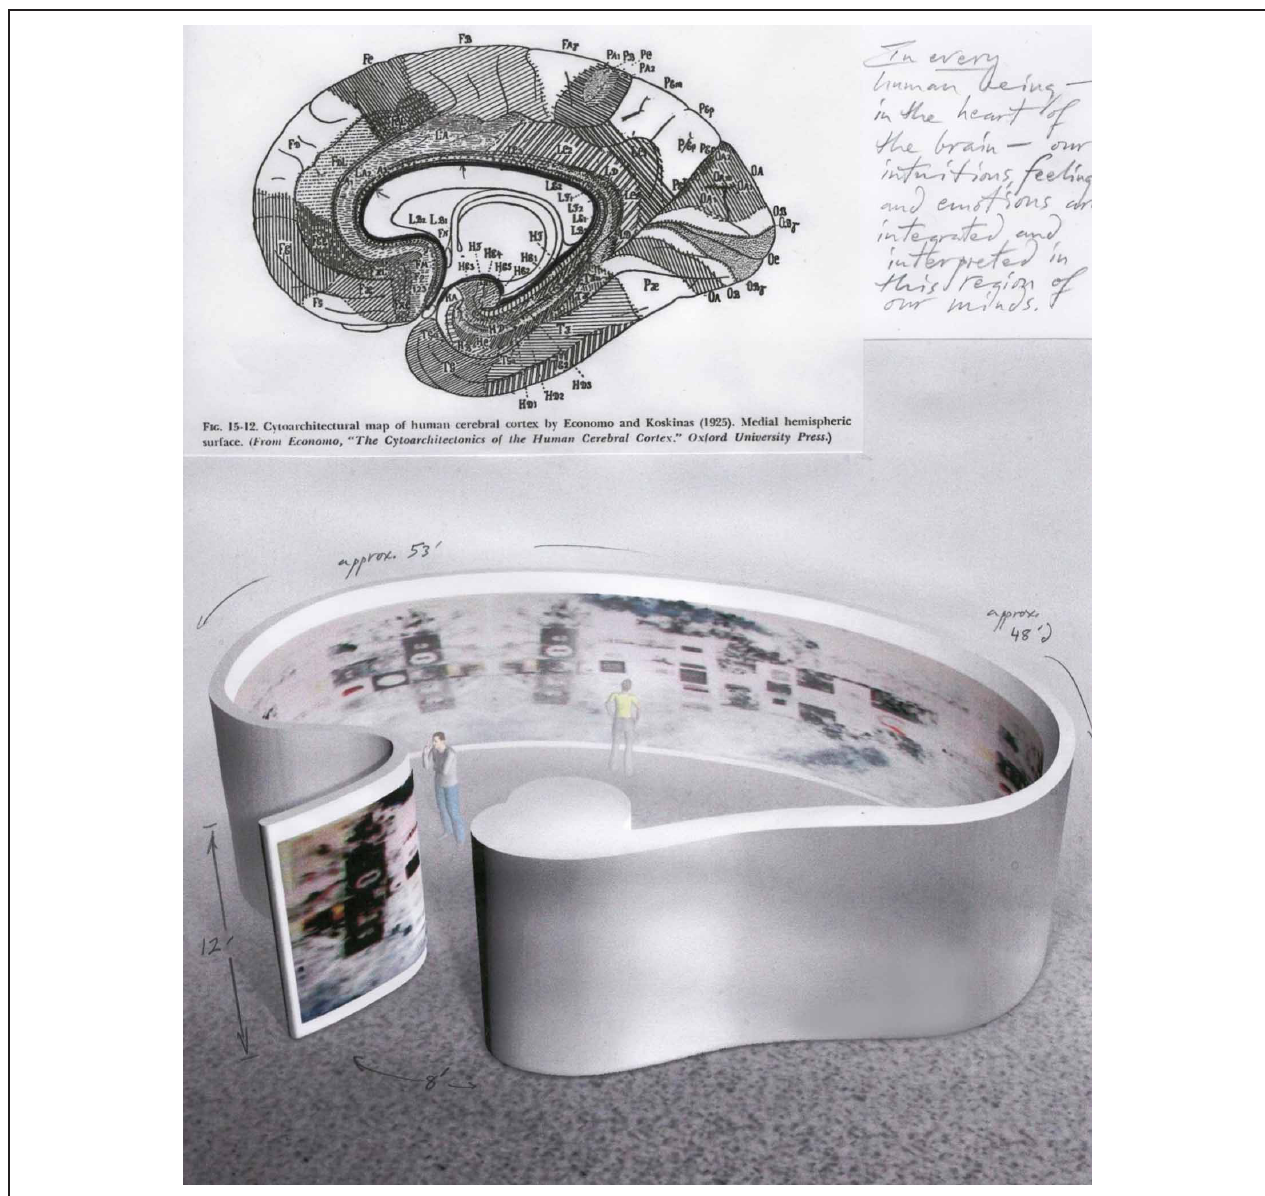
FIGURE 2 | “The Organizing Principle for Thought-Assemblies ” (1979–1982). Ink on paper, 10 . 5 × 8 . 5